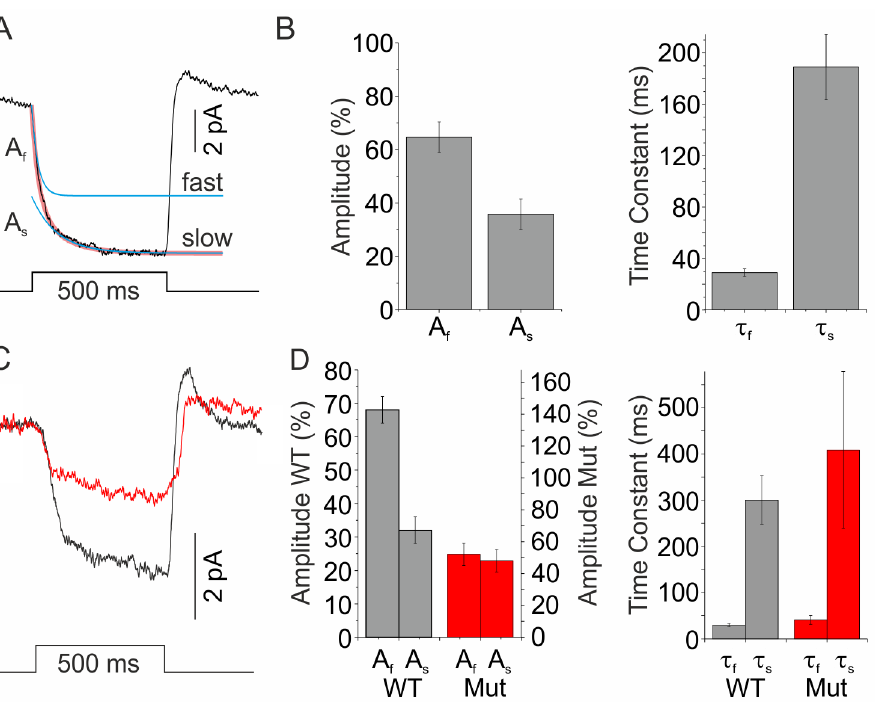
Figure 1. Feedback consists of a fast and a slow component. (A) Feedback response measured in a cone in goldfish retina. Cones were clamped at E Cl ( 2 50 mV) and saturated with a small spot of light. HCs were then hyperpolarized by a 500 ms full-field white light stimulus (4,500 m m). This induced a feedback inward current. The mean amplitude was 11.0 6 1.1 pA ( n =23). The onset of the feedback response could be fitted best by the sum of two exponentials (red line, sum of the exponential fits; blue lines, individual exponential fits). (B) The amplitude and time constants of the two exponential functions. The fast feedback component ( t f =29 6 3 ms; n =23) had an amplitude (A f ) that constituted 64 6 6% of the total feedback response. The remaining 36 6 6% of the feedback response (A s ) was mediated by a process with a time constant ( t s ) of 189 6 25 ms ( n =19). (C) Feedback responses in cones from wild-type (WT, black) and Cx55.5 2 / 2 mutant zebrafish (red) were also best fitted by a double exponential function. (D) Compared to goldfish, WT zebrafish had a similar fast component to slow component amplitude ratio (gray: A f , 68 6 4%; A s , 32 6 4%; n =13), whereas it shifted in Cx55.5 2 / 2 mutants in favor of the slow feedback component (red: A f , 52 6 7%; A s , 48 6 7%; n =9). The amplitude of the slow component of feedback in Cx55.5 2 / 2 mutants (1.62 6 0.39 pA; n =9) did not significantly differ from WT (1.87 6 0.39 pA; n =13; p =0.67), showing that the slow component is independent of Cx55.5 hemichannels. Note that the amplitude axes for the WT and mutants are scaled such that it reflects the total reduction of feedback in the mutant relative to WT. The time constant of the fast component ( t f ) did not differ significantly between WT and Cx55.5 2 / 2 mutants (WT, 29.3 6 3.3 ms; n =13; Cx55.5 2 / 2 , 40.6 6 9.6 ms; n =9; p =0.21) and was similar to goldfish. The time constant of the slow component (